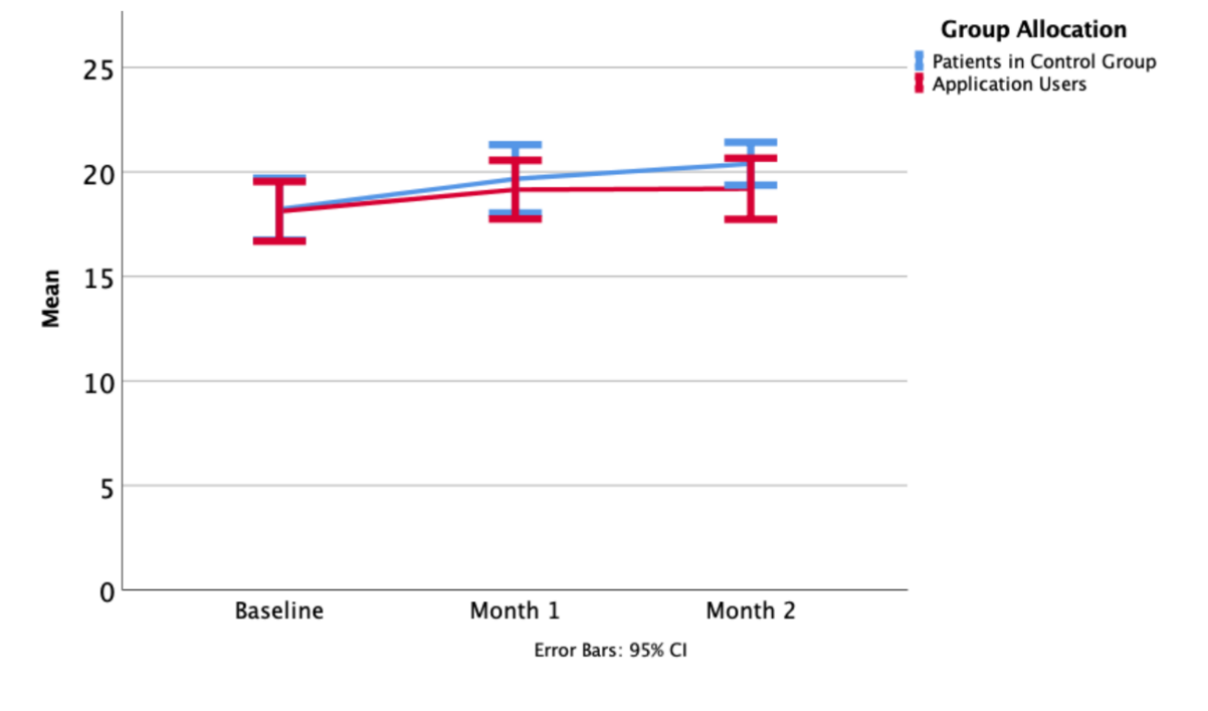
Table 2. Structured feedback using Likert scales with values from 1 (strongly disagree) to 5 (strongly agree).